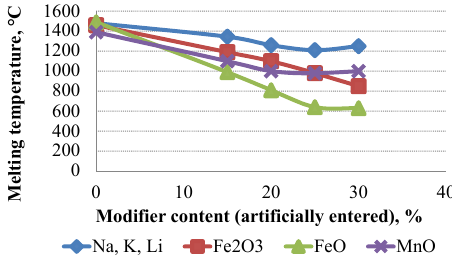
Fig. 4. The effect of modifiers on the melting temperature of the basalt charge